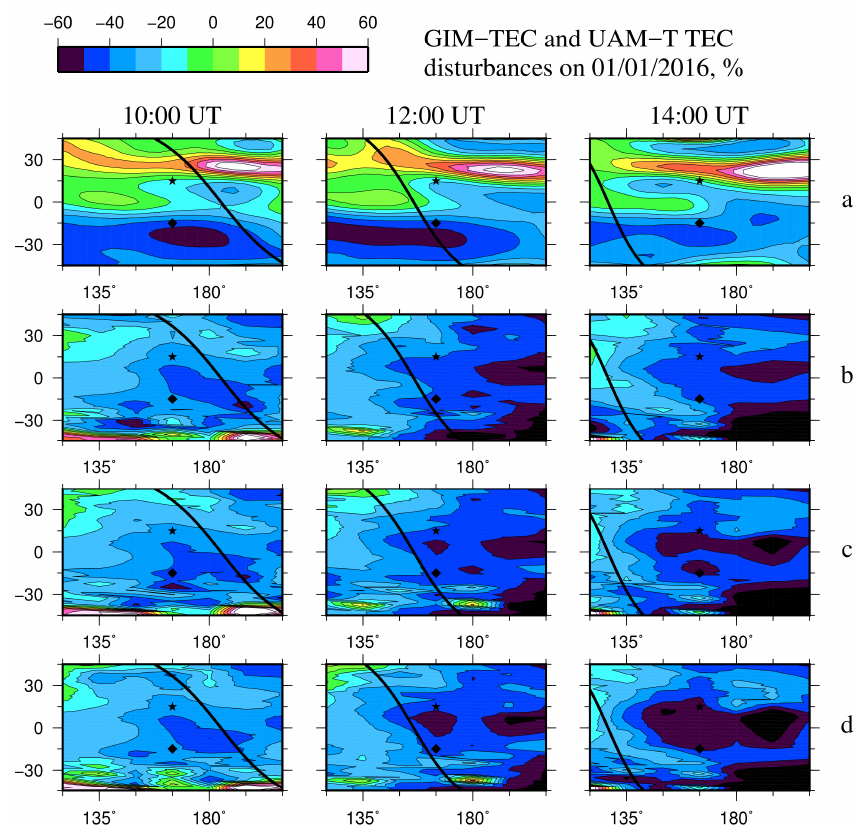
Figure 1. GPS observed and UAM-T (self-consistent UAM version) calculated total electron content (TEC) disturbances (%) relative to the background values in the geomagnetic coordinates at 10:00–14:00 UTC on January 1, 2016: ( a ) Global ionosphere maps of the total electron content (GIM-TEC); ( b ) UAM-T calculated without currents; ( c ) UAM-T calculated with j s = 20 nA / m 2 ; ( d ) UAM-T calculated with j s = 40 nA / m 2 . Black line denotes the terminator, black star and diamond represent the earthquake epicenter and magnetically conjugated point, respectively.